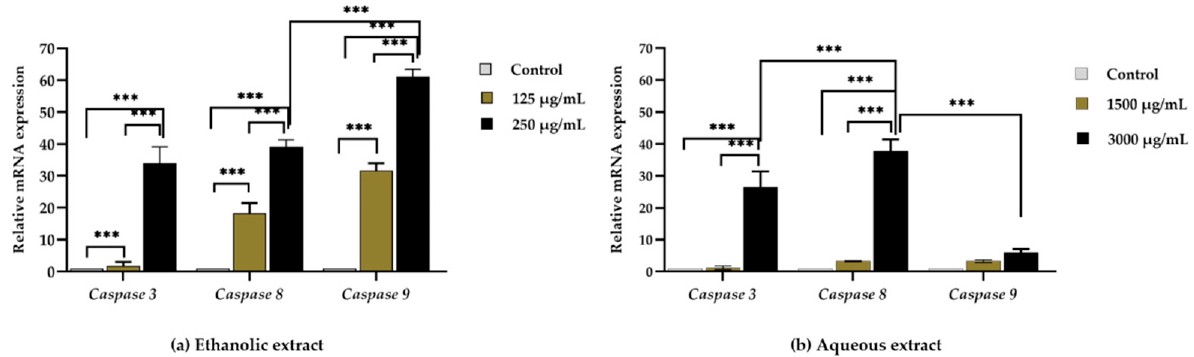
Figure 7. The qRT-PCR analysis of apoptosis-related gene after 3 h of treatment of Caco-2 cell with red jasmine rice ethanolic extract ( a ) and aqueous extract ( b ), compared with untreated cell control. Data are expressed as mean ± SD ( n = 3 independent assays). (*** indicated, p < 0.0001).